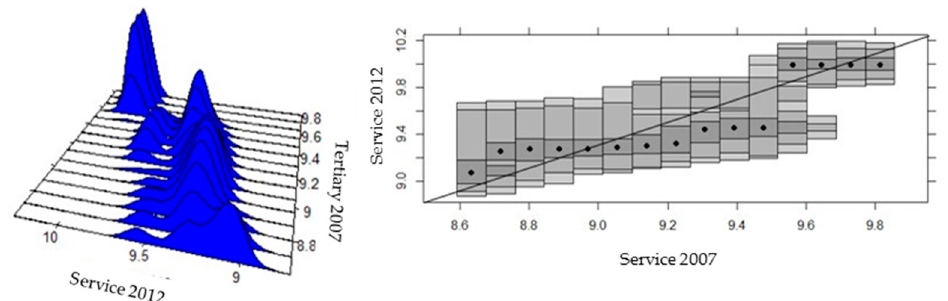
Figure 7. Intra-distribution dynamics of provincial productivity in the service sector, 2007–2012. Source: Own elaboration based on the Regional Accounts of the BCE [46]; ENEMDU surveys from the INEC [47] (several years) and stacked conditional density plot (SCD) in R.